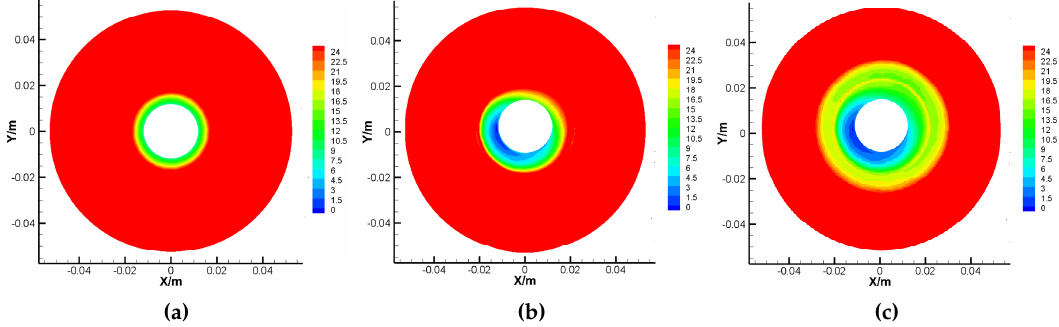
Figure 10. Pressure contours of the upper surface of the rotor under φ y = 0 ◦ . ( a ) Results under φ x = 0 ◦ and 3500 rpm; ( b ) Results under φ x = 5 ◦ and 3500 rpm; ( c ) Results under φ x = − 5 ◦ and 2000 rpm.